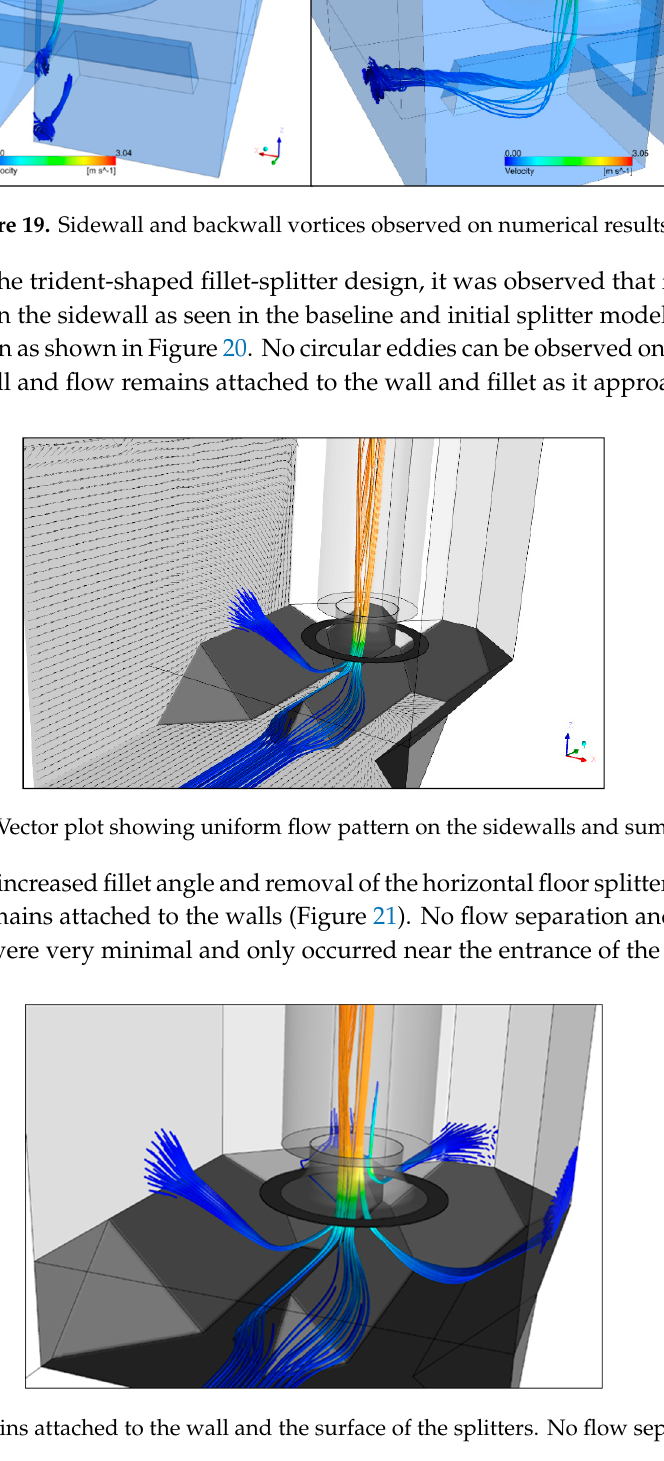
Figure 21. Flow remains attached to the wall and the surface of the splitters. No flow separation